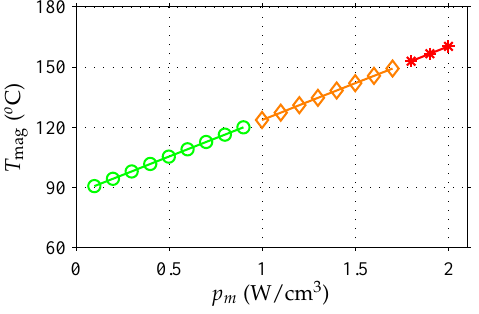
Figure 13. Resulting PM average temperature as a function of PM volumetric loss density p m at rated current and 9000 rpm. The considered low, medium and high temperature ranges have been indicated using green, orange and red colors, respectively.